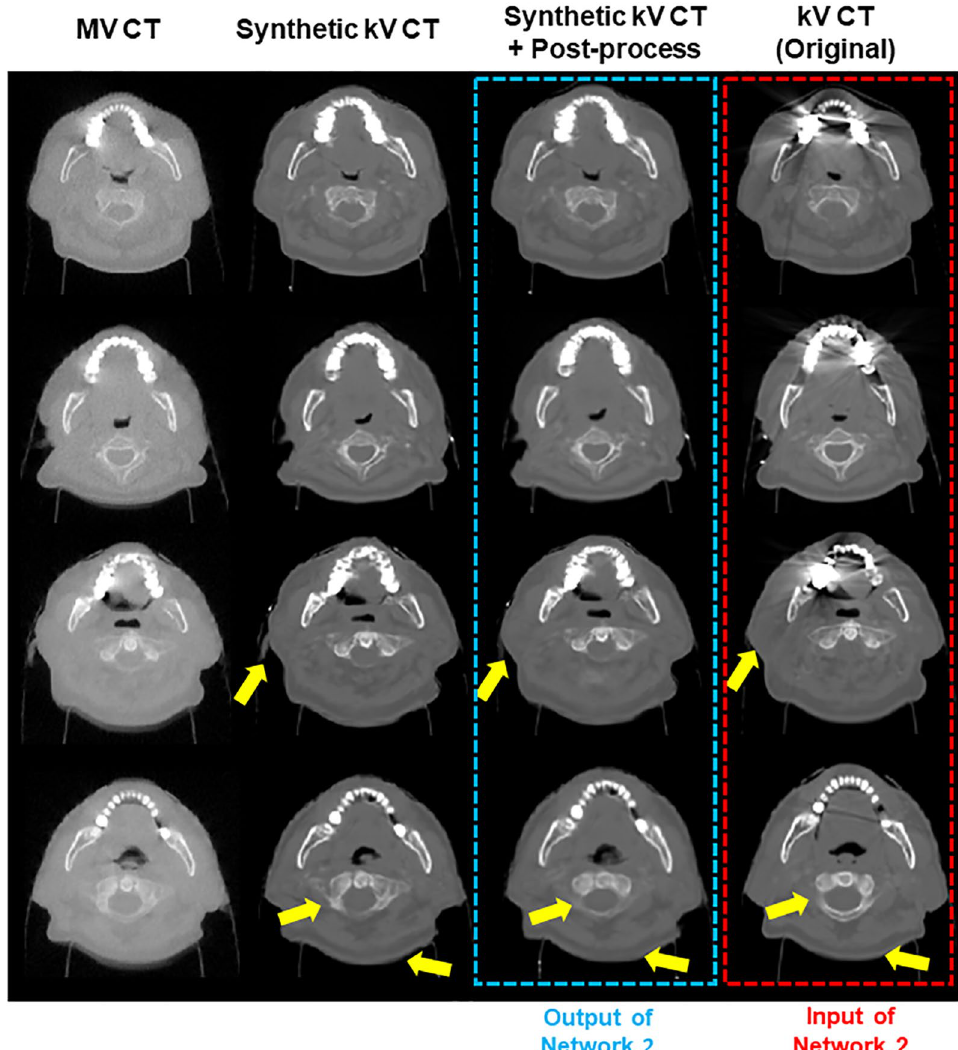
Figure 5. The results of Network1 (Synthetic kV CT) from MV CT and the images through additional processing (Synthetic kV CT + Additional Process) for 2D slices containing metal elements, compared against